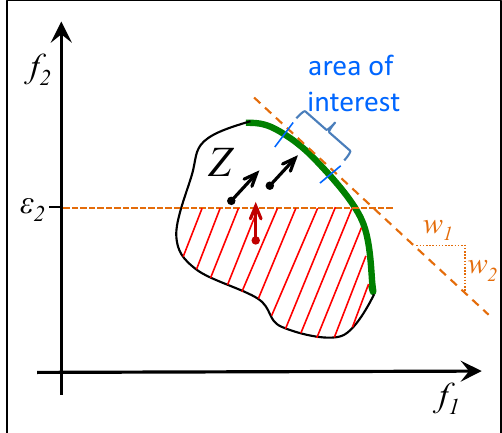
Figure 6. Cascaded weighted sum for k = 2 and objective two having a higher priority than objective one. Thus, solutions in the hatched area are bettered according to f find the largest quality gain in upward moves ( red arrow ). This changes, if ε and f starts to contribute to the resulting sum, as shown by the black arrows. 1